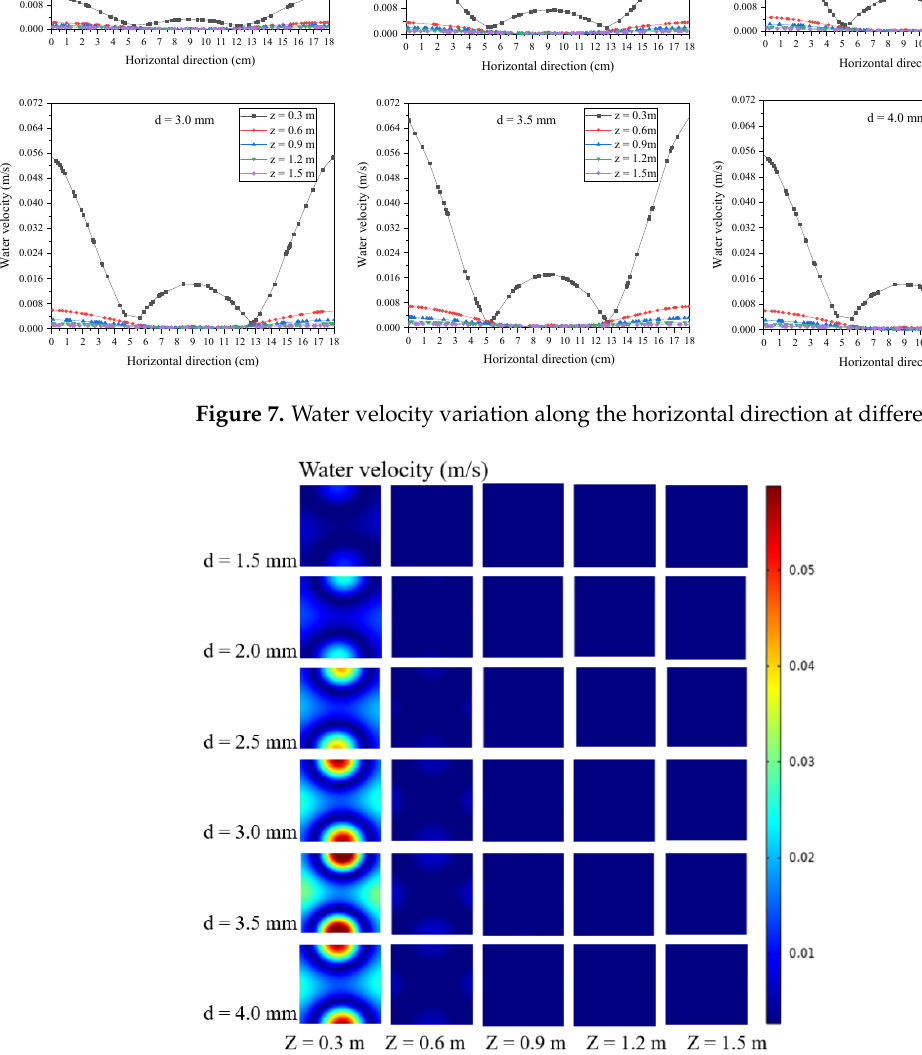
Figure 8. Cloud map of the water velocity variation along the horizontal direction at different orifice diameters.